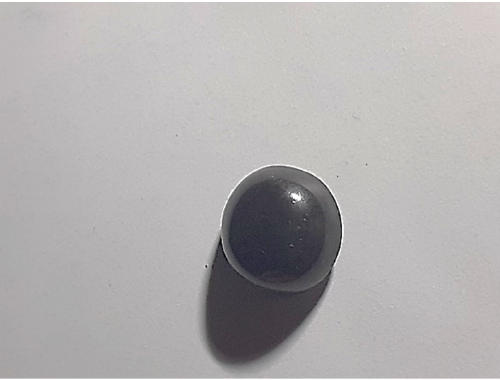
Figure 9. Quartz round cabochon (diameter 11 mm, Table 1, sample 2) with small veins of anhydrite.